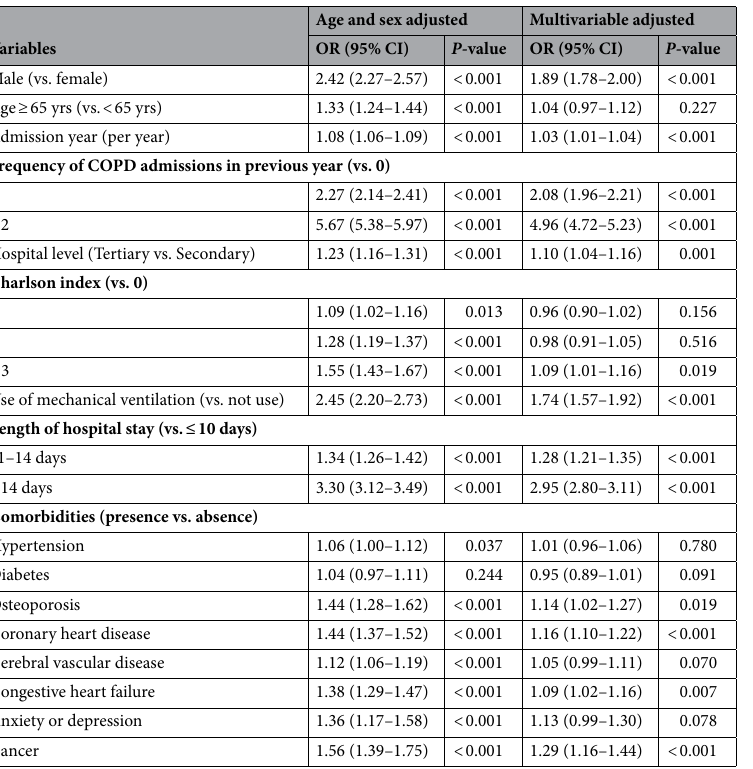
Table 3. Multivariable analysis of factors at index admission associated with 30-day COPD readmission risk (n = 131 591). ORs were estimated using logistic models with a random effect to account for multiple admission year at index